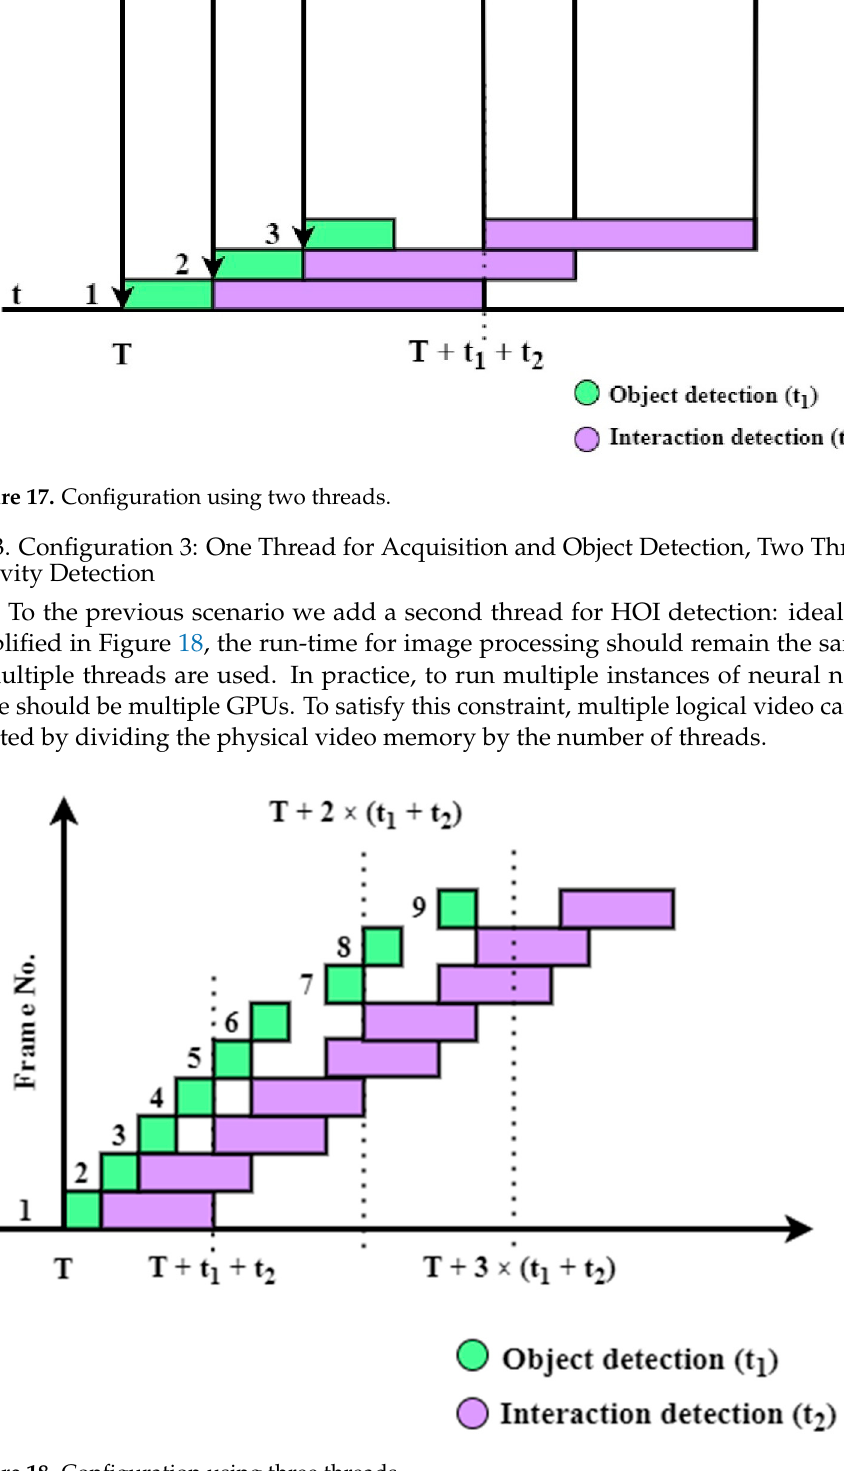
Figure 18. Configuration using three threads.